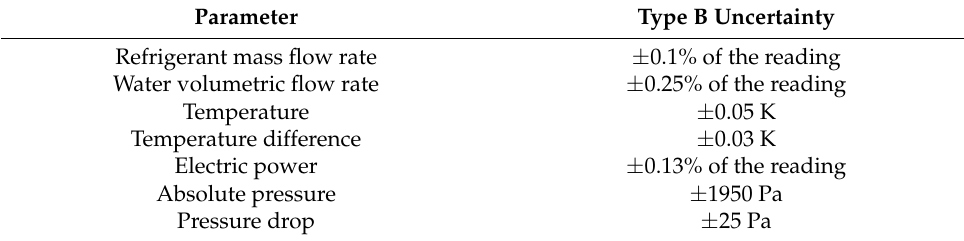
Table 1. Type B experimental uncertainty of measured